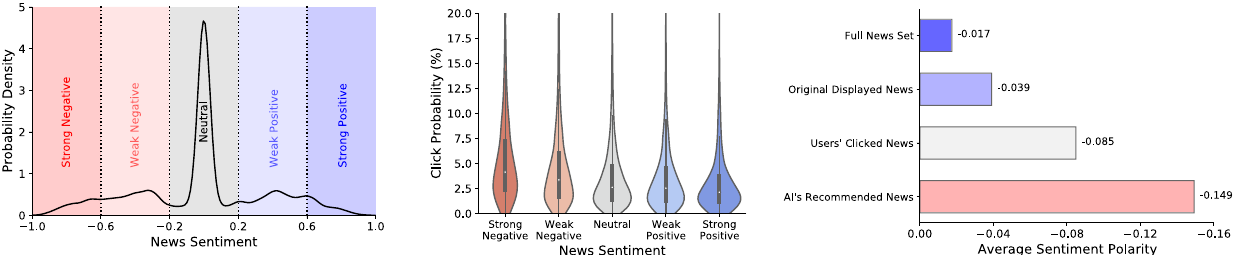
Fig. 3 Sentiment bias and AI ’ s sentiment manipulation. Left: the sentiment distribution of news in the dataset. We categorize the sentiment polarities according to the real-valued sentiment scores. Most news has very weak or neutral sentiment while other has positive or negative sentiment orientation with stronger intensities. The overall sentiment of the news corpus is nearly neutral (the average sentiment score is − 0.0174). Middle: the click probability of news with different sentiment polarities. News articles with more negative sentiments are more likely to be clicked by users, which is the core source of sentiment bias. The differences in click probabilities among different sentiment polarity categories are signi fi cant ( p < 0.001 according to two-sided t - tests). Right: average sentiment scores of the full news set, the news displayed to users in the training data, users ’ clicked news in the training data, and top 50 recommendation results given by a state-of-the-art news recommendation model NRMS (Wu et al., 2019c). The negative sentiment is ampli fi ed in a cascaded way due to users ’ biased news reading choices and AI ’ s algorithm biases learned from user data. This provides evidence of AI ’ s news sentiment manipulation in the loop of human-machine interactions on news delivery